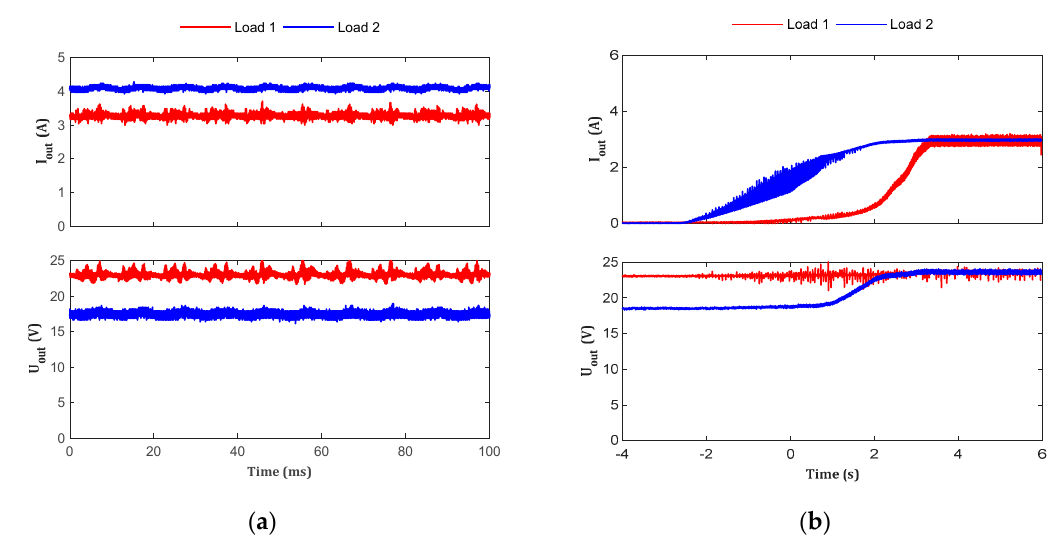
Figure 21. Output current and voltage waveforms of two separate SEPIC cells operating with different loads ( a ), charge balancing at the output capacitances of parallel connected cells ( b ).